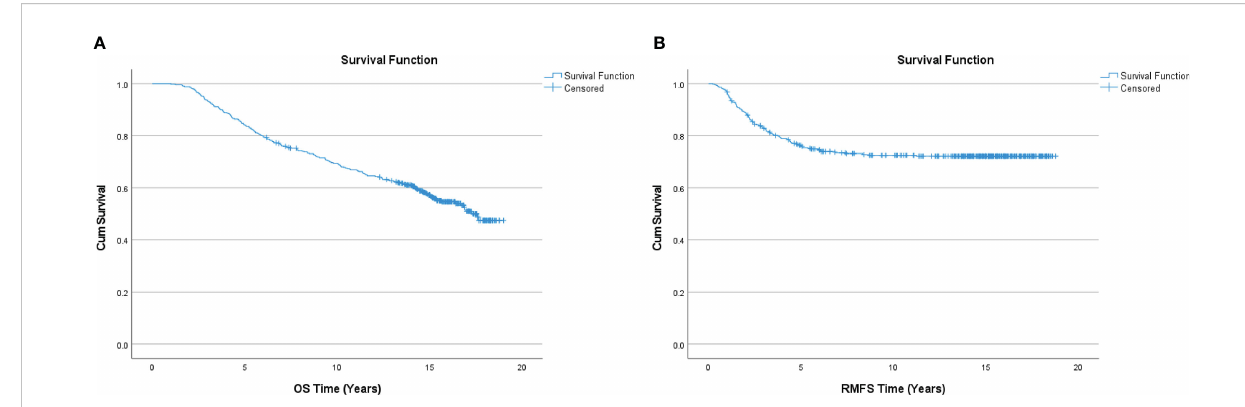
FIGURE 1 (A) Kaplan Meier curve for overall survival (OS). (B) Kaplan Meier curve for local or distant recurrence-free survival